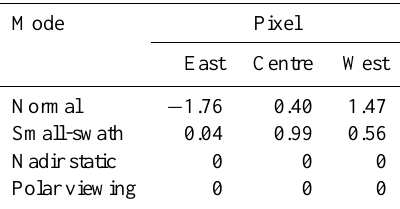
Table A2. The correction (DU) as function of view angle for the TOGOMI data set.